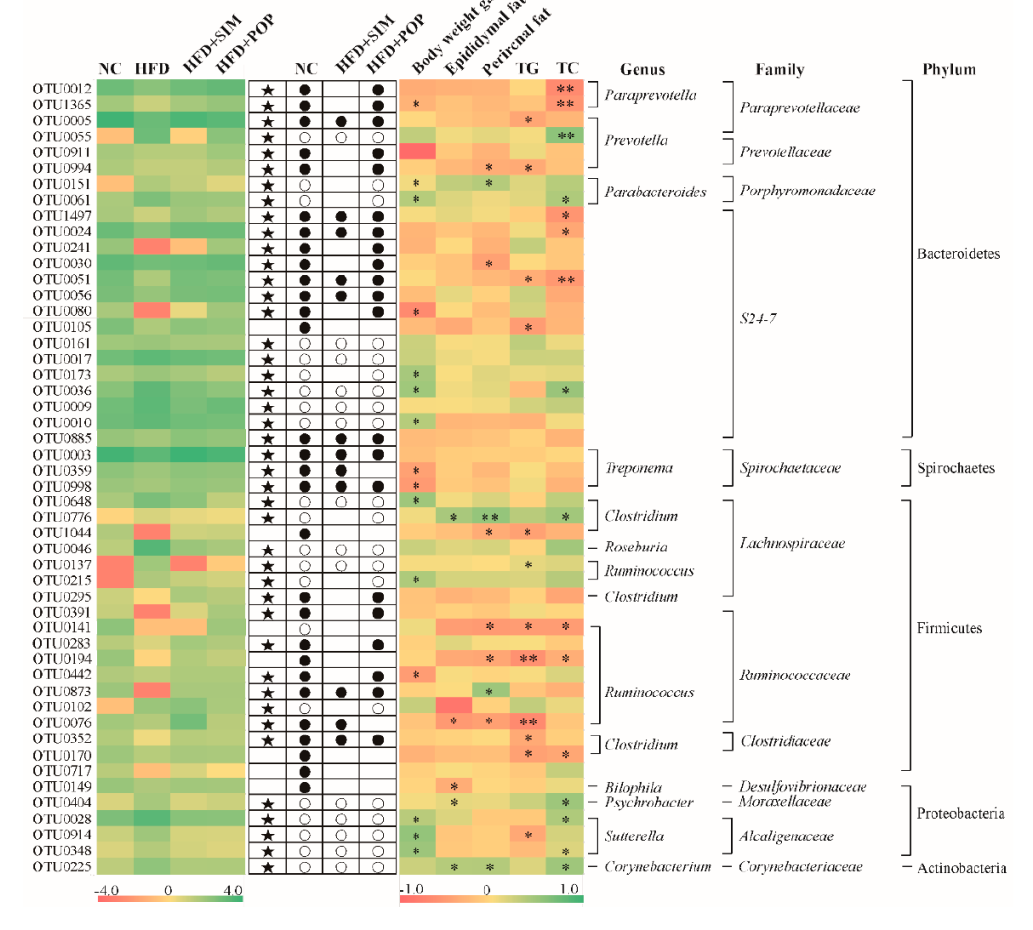
Figure 7. Heat map of RDA-identified key OTUs in response to POP treatment according to Spearman’s correlations between the identified OTUs and weight gain, epididymal fat, perirenal fat, and liver TG and TC levels. Colors of squares on the left indicate the average abundance of the OTU in each group. Open ( ○ ) and closed ( ● ) circles represent lower and higher relative abundances (log 10 transformed), respectively, of OTUs in NC, HFD + SIM, or HFD + POP groups compared with that in the HFD group. Stars ( ) indicate OTUs in the NC group altered by HFD intervention that were restored by POP or SIM treatment. Colors of squares on the right indicate R -values of Spearman’s correlation between OTU and weight gain, epididymal fat, perirenal fat, and liver TG and TC levels. Phylum, family, and genus names of the OTUs are shown on the right. * p < 0.05 and ** p < 0.01.